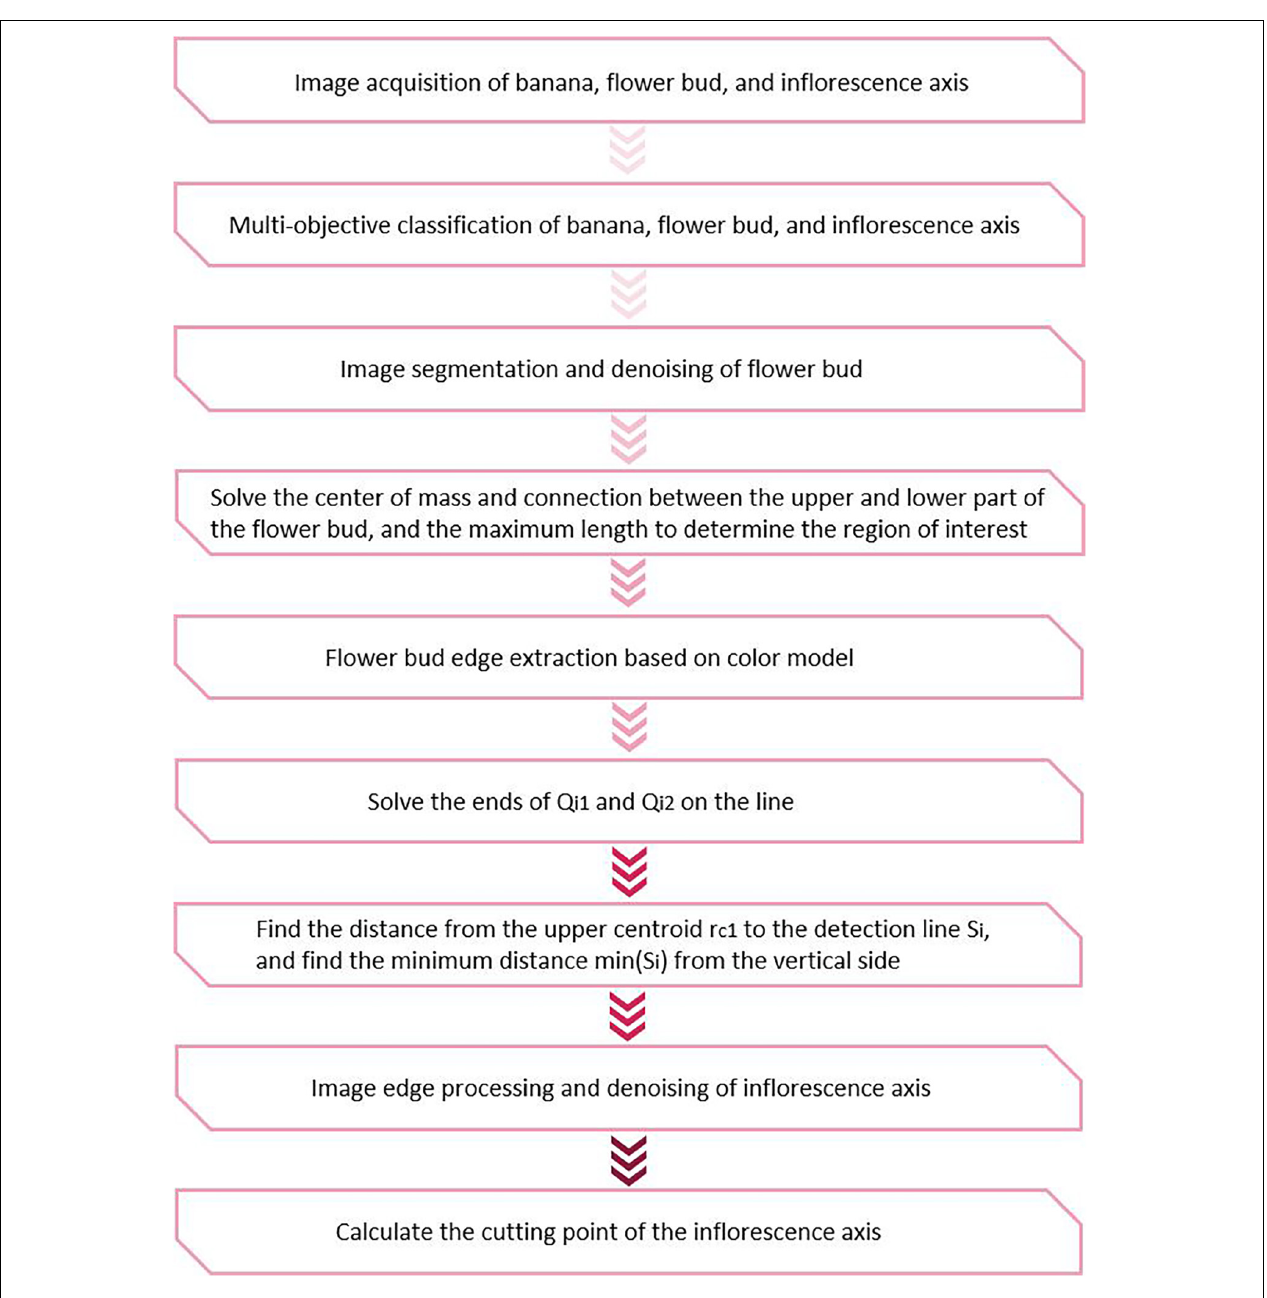
FIGURE 5 | Flowchart of cutting point